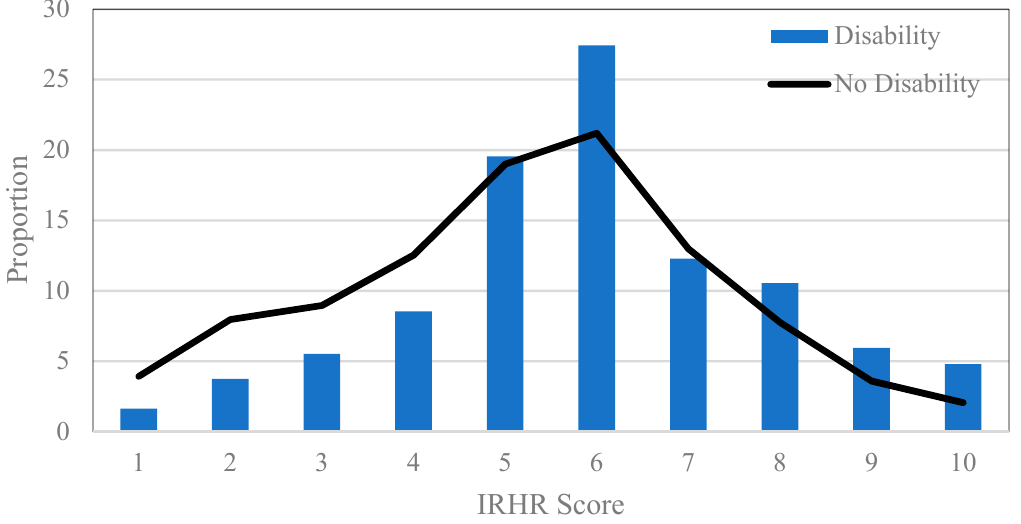
Figure 2. Index of Relative Homelessness Risk by all disability and long-term conditions versus no impairment (pre-NDIS).